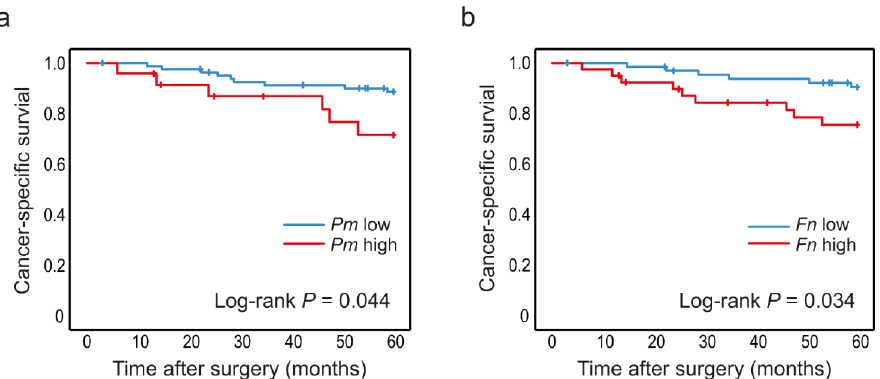
Cancers 2022 , 14 , x